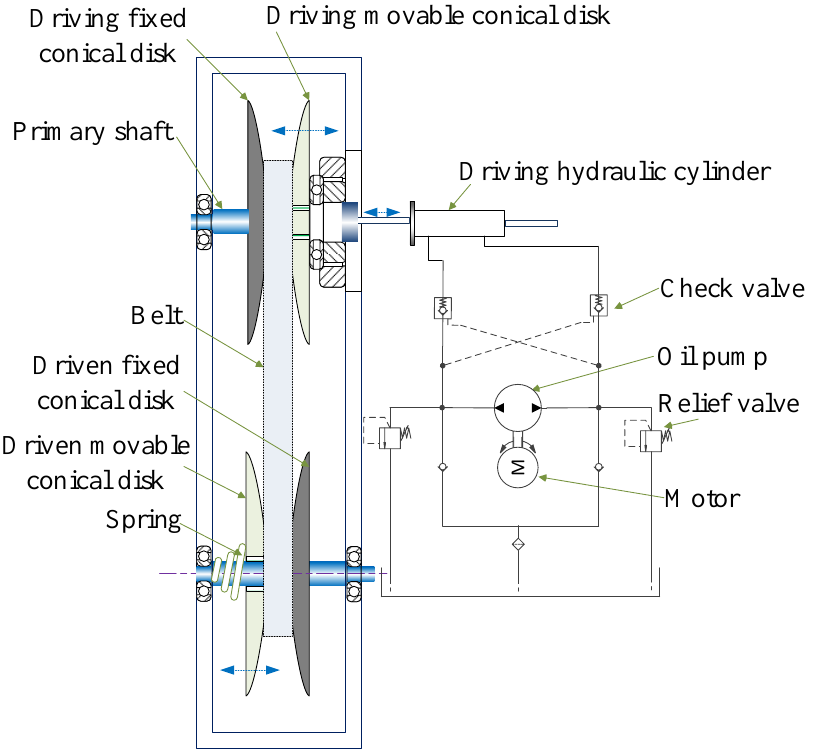
Figure 2. Electro-hydraulic actuator (EHA) continuously variable transmission (CVT) system.